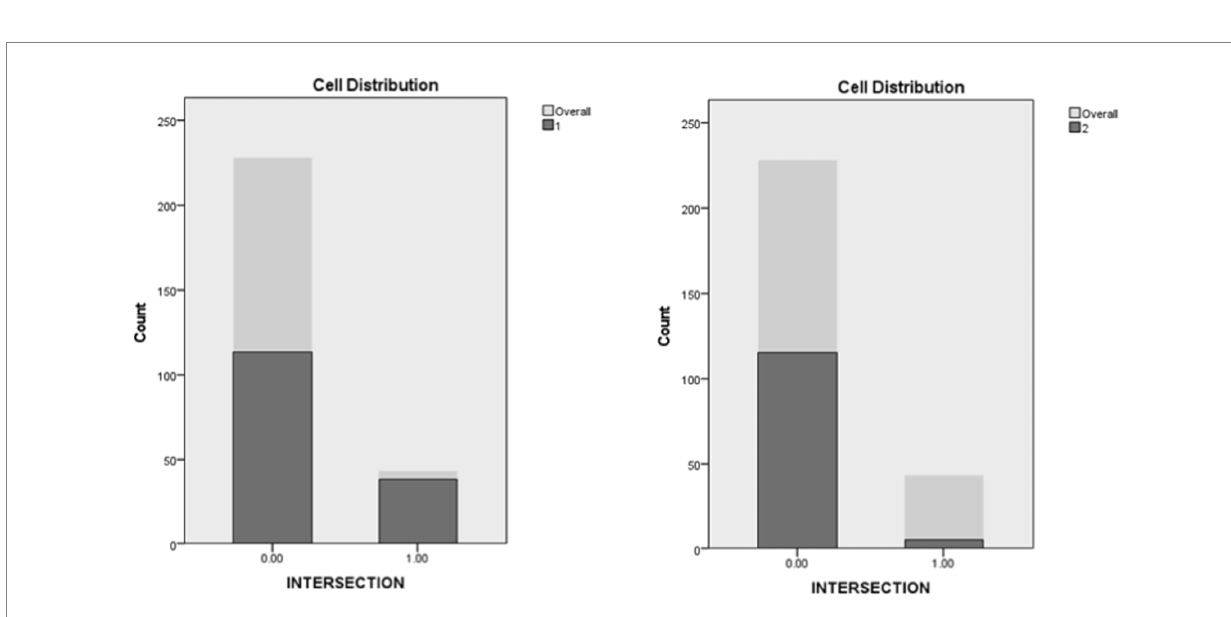
FIGURE 12 Intersections entered distribution in